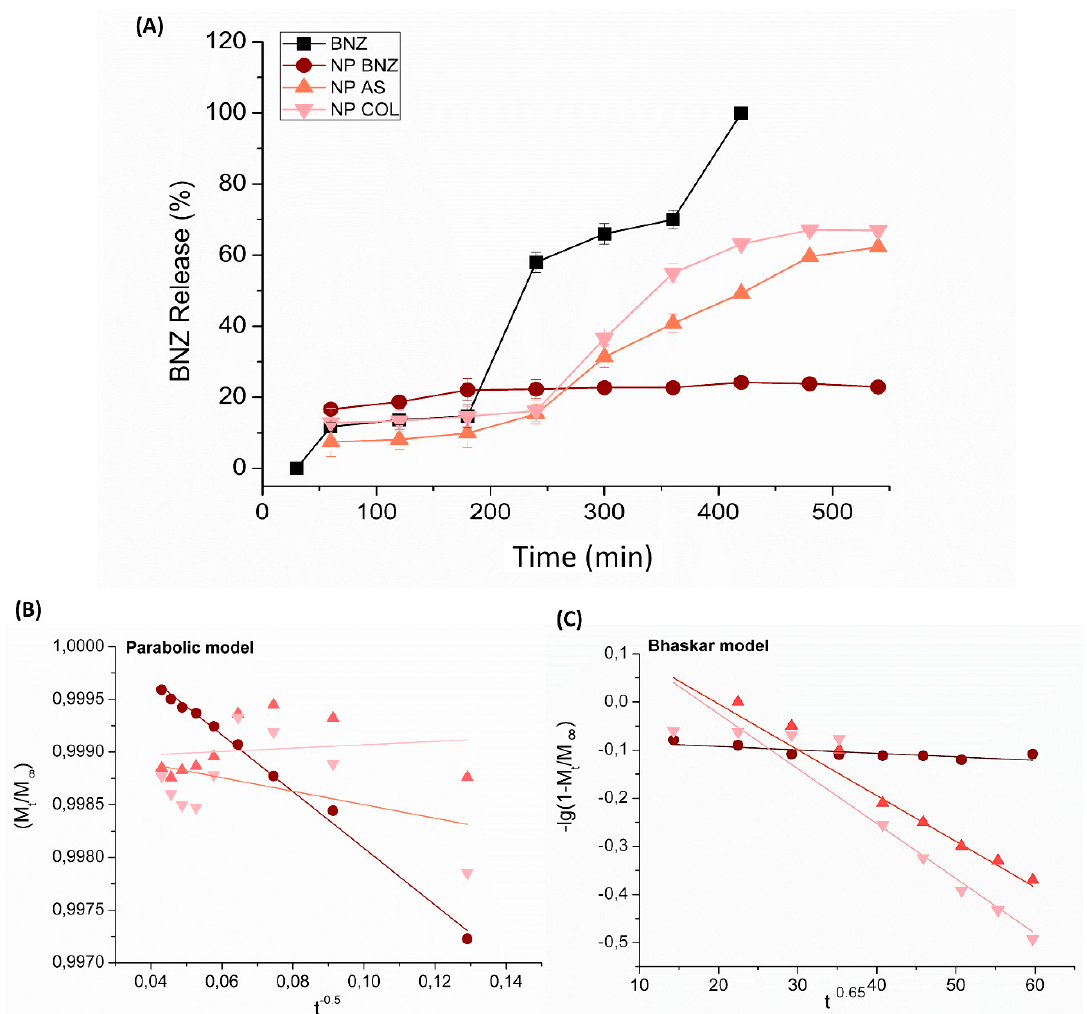
Figure 4. ( A ) Experimental in vitro drug release profile from different formulations. Respective mathematical modeling adjustment of data using ( B ) a parabolic model and ( C ) the Bhaskar model. Notes: The different samples can be identified as follows: ( (cid:4) ) Solution of pure BNZ; ( (cid:8) ) NP BNZ; ( (cid:78) ) NP BNZ SA; and ( (cid:72) ) NP BNZ Chol. The data are expressed as the mean ± standard deviation (SD) ( n = 3). Table 2. Fitting parameters for different kinetic models applied to the in vitro BNZ release data from cationic NPs.